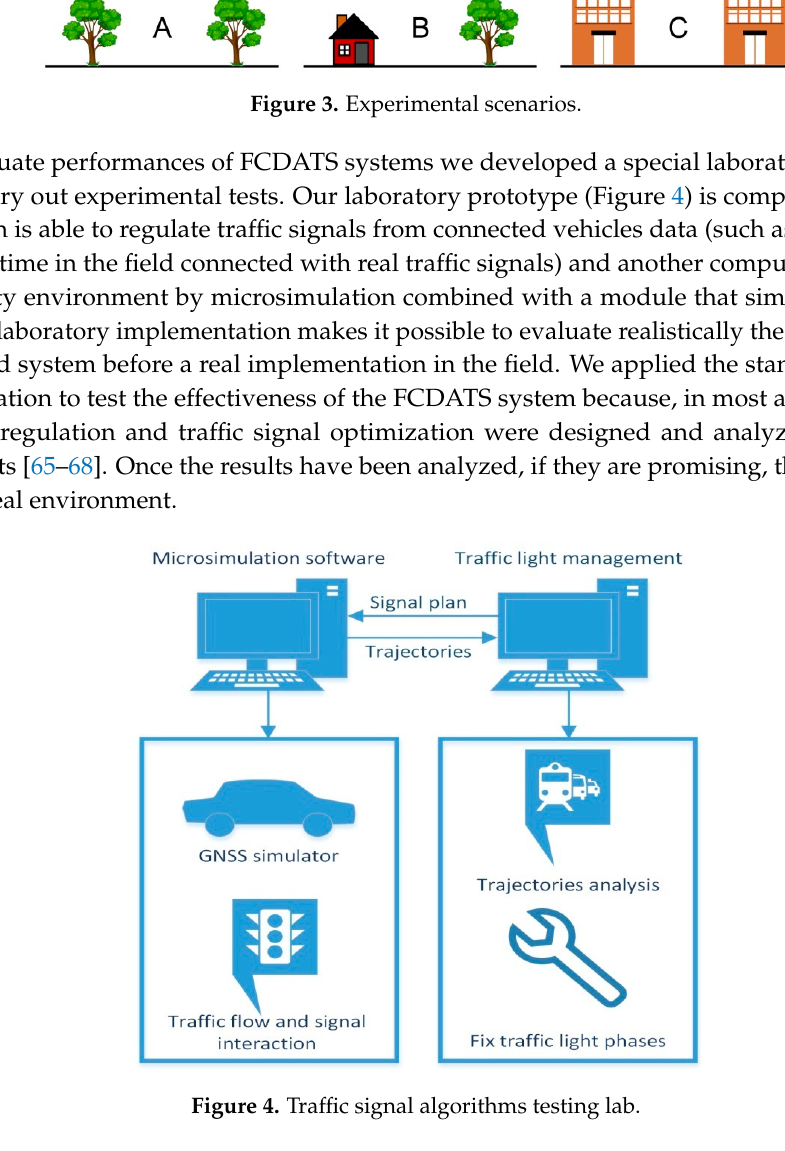
Figure 4. Traffic signal algorithms testing lab.